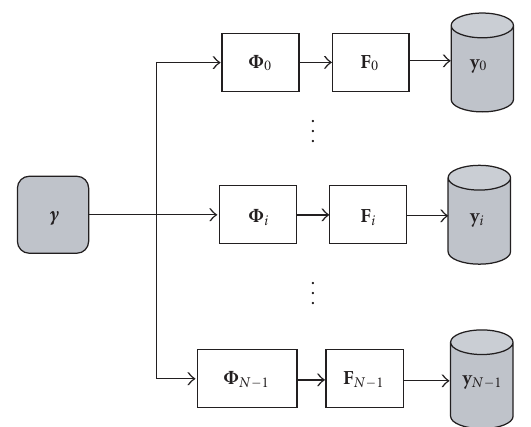
Figure 2: Multi-baseline interferometric SAR system, modeled as a SIMO system corresponding to (4).